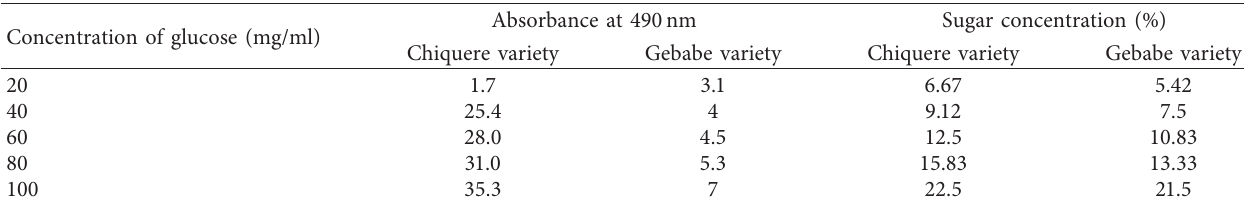
Table 2: Absorbance of glucose by Chiquere and Gebabe varieties of sweet sorghum by using UV-visible spectrophotometer. Concentration of glucose (mg/ml)